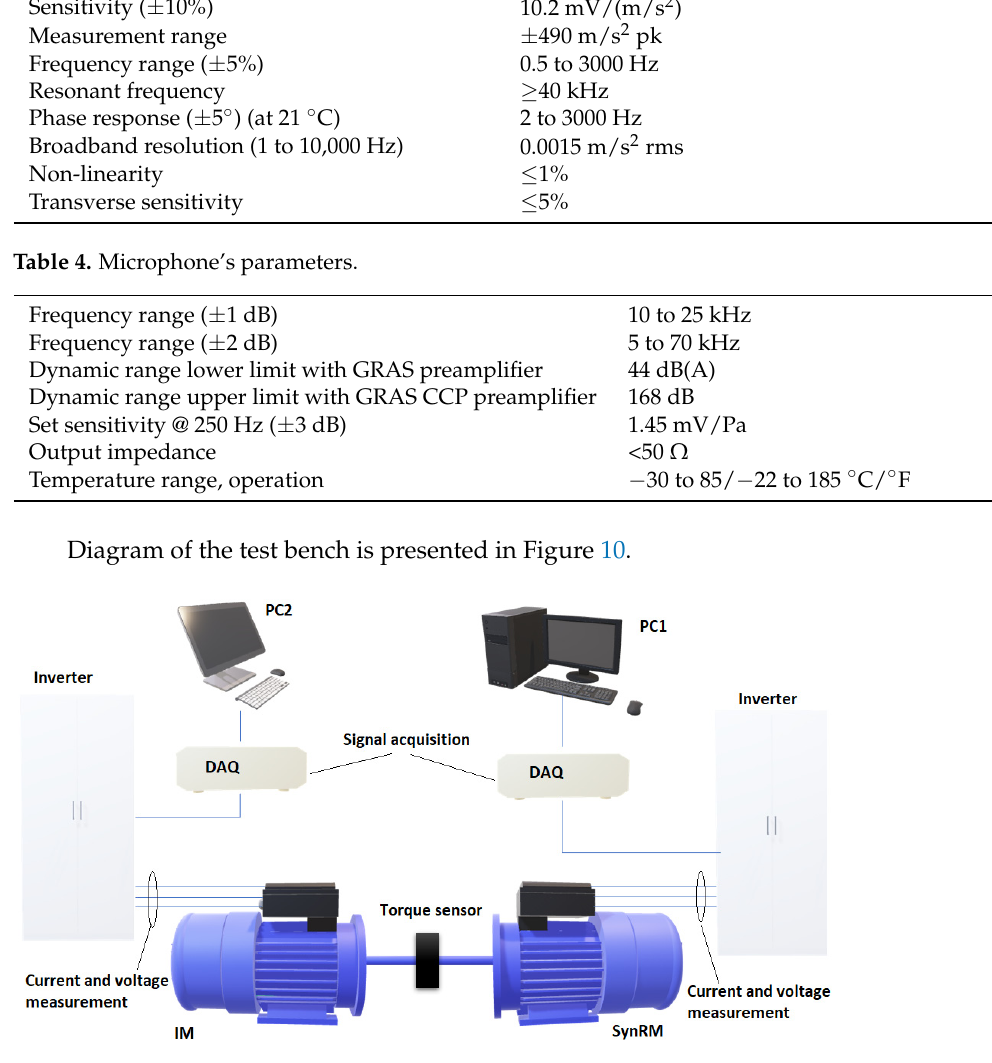
Figure 10. Test bench system diagram .